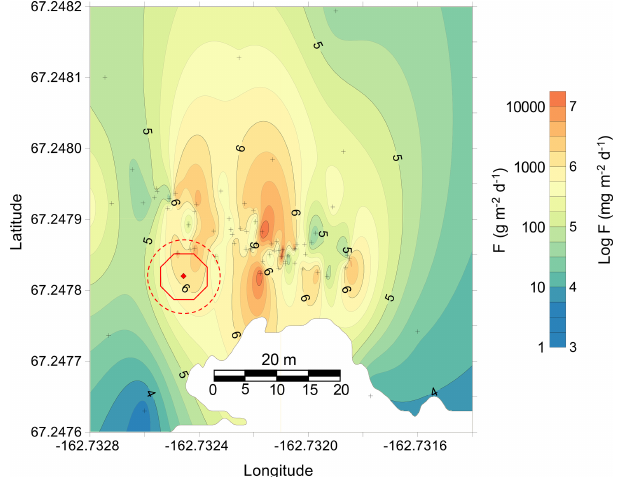
Figure 6. Map of CH 4 emissions in a region of Esieh Lake with large gas seeps; black crosses ( + ) indicate central location of tran- sect measurements. This map scale is metric (i.e. same distance scale in both axes). Please note the logarithmic color scale. Red oc- tagon indicates the location of the bubble trap, while the dotted red circle represents potential coordinates error between MOD chamber and bubble trap deployments (i.e. ± 4m; see text for